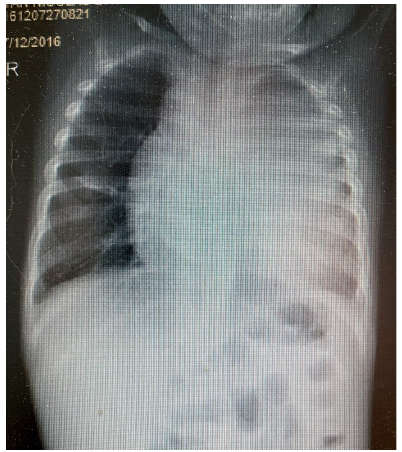
Figure 2. Anteroposterior chest radiography.